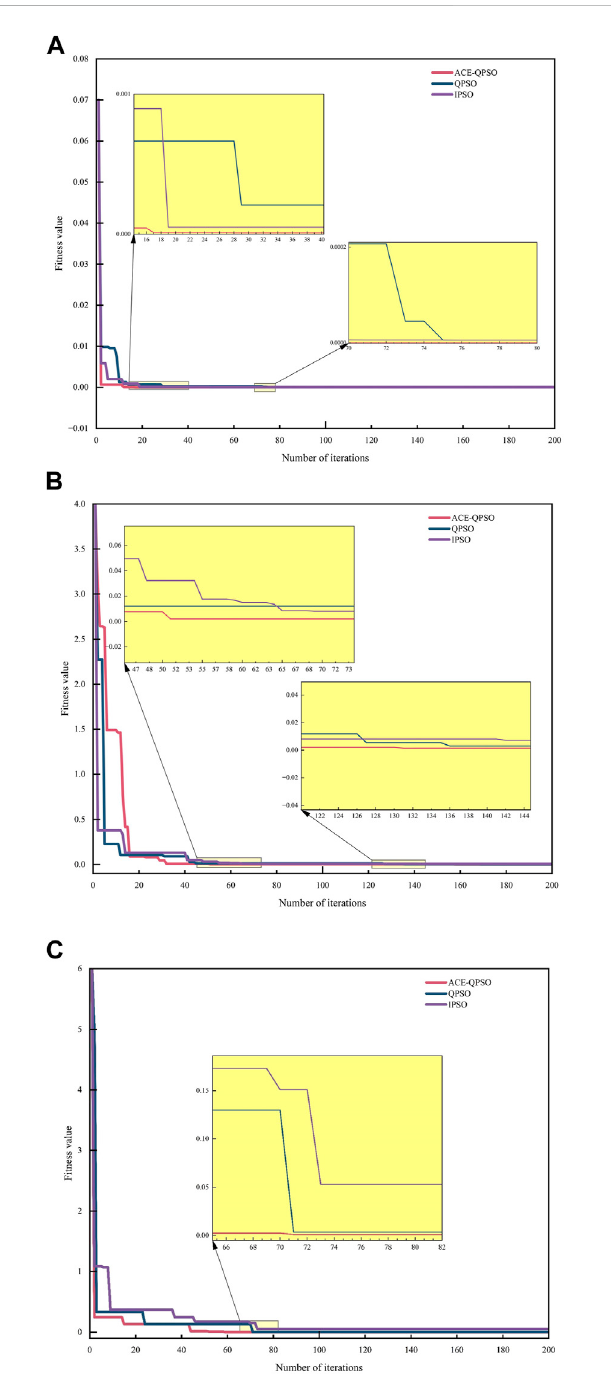
The convergence curves of each algorithm on the three benchmark functions of (A) – (C) , respectively: (A) Sphere function; (B) Ackley function; (C) Griewank